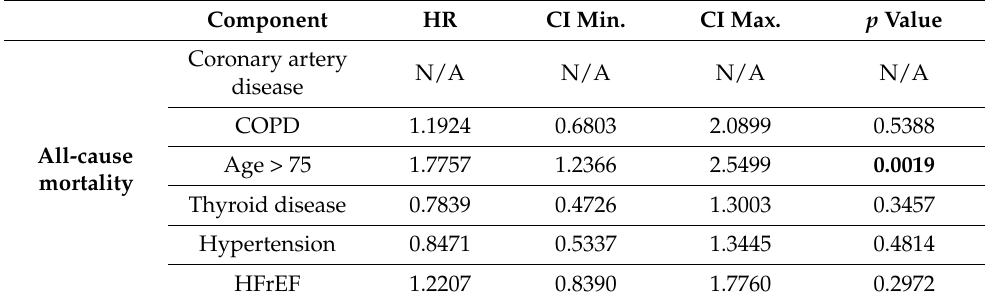
Table 10. Associations of individual C 2 HEST score components with mortality in CAD cohort. Component HR CI Min. CI Max.